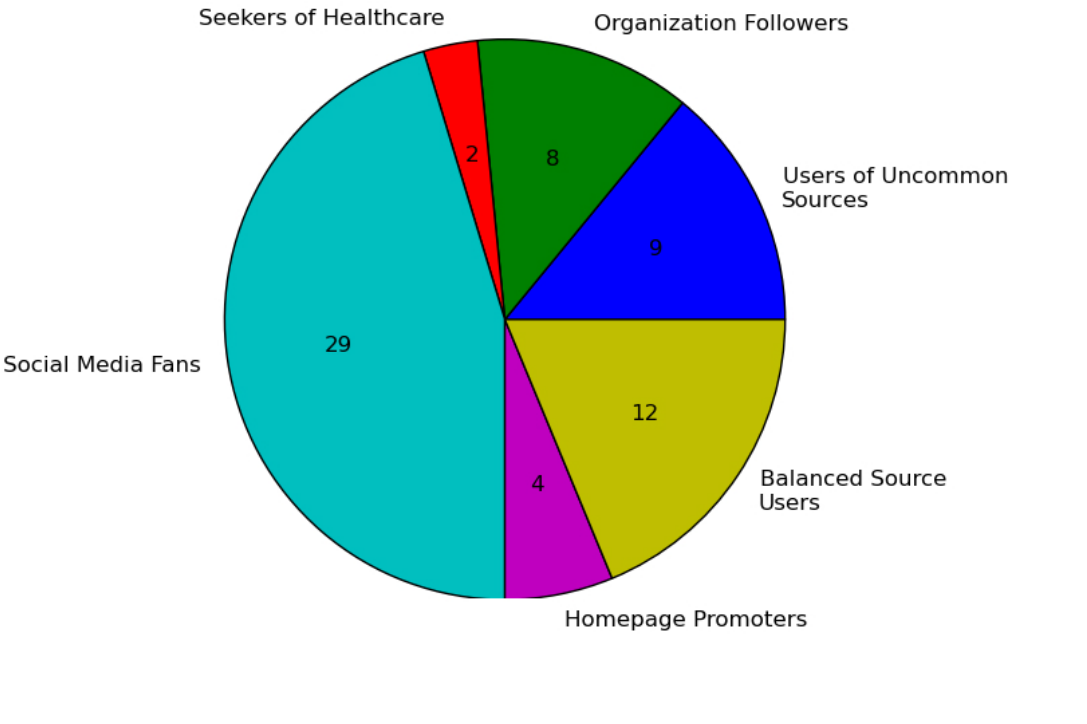
Figure 5. Reference use clusters with number of users in each cluster (n=64 included